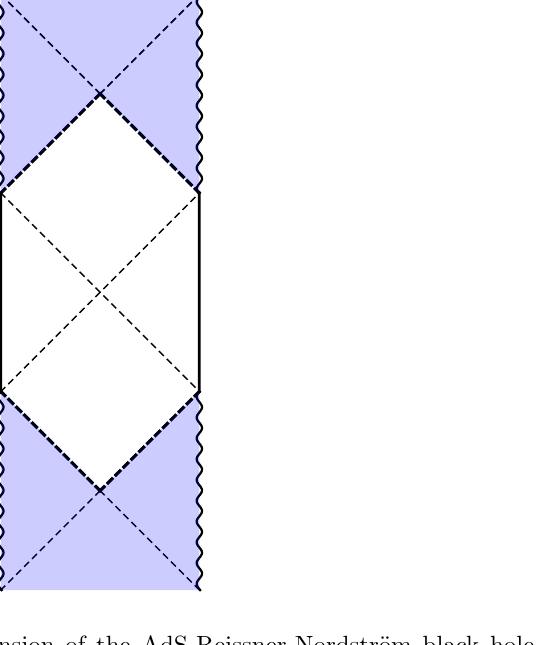
Figure 1 . The maximal analytic extension of the AdS-Reissner-Nordstr(cid:127)om black hole. for our study in section 2.2 we truncate it to the AdS-hyperbolic unshaded region between the past and future (AdS-) Cauchy horizons (heavy dashed